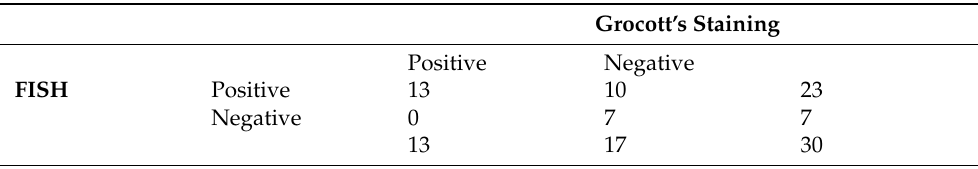
(Figure 1), the FISH assay applying the PJ1 probe achieved 100% sensitivity and 41% specificity with an overall concordance of 66.7% (Table 1). Table 1. Comparison of Grocott’s staining results and FISH staining results with paraffin-embedded tissues. Grocott’s staining was used as the reference standard.